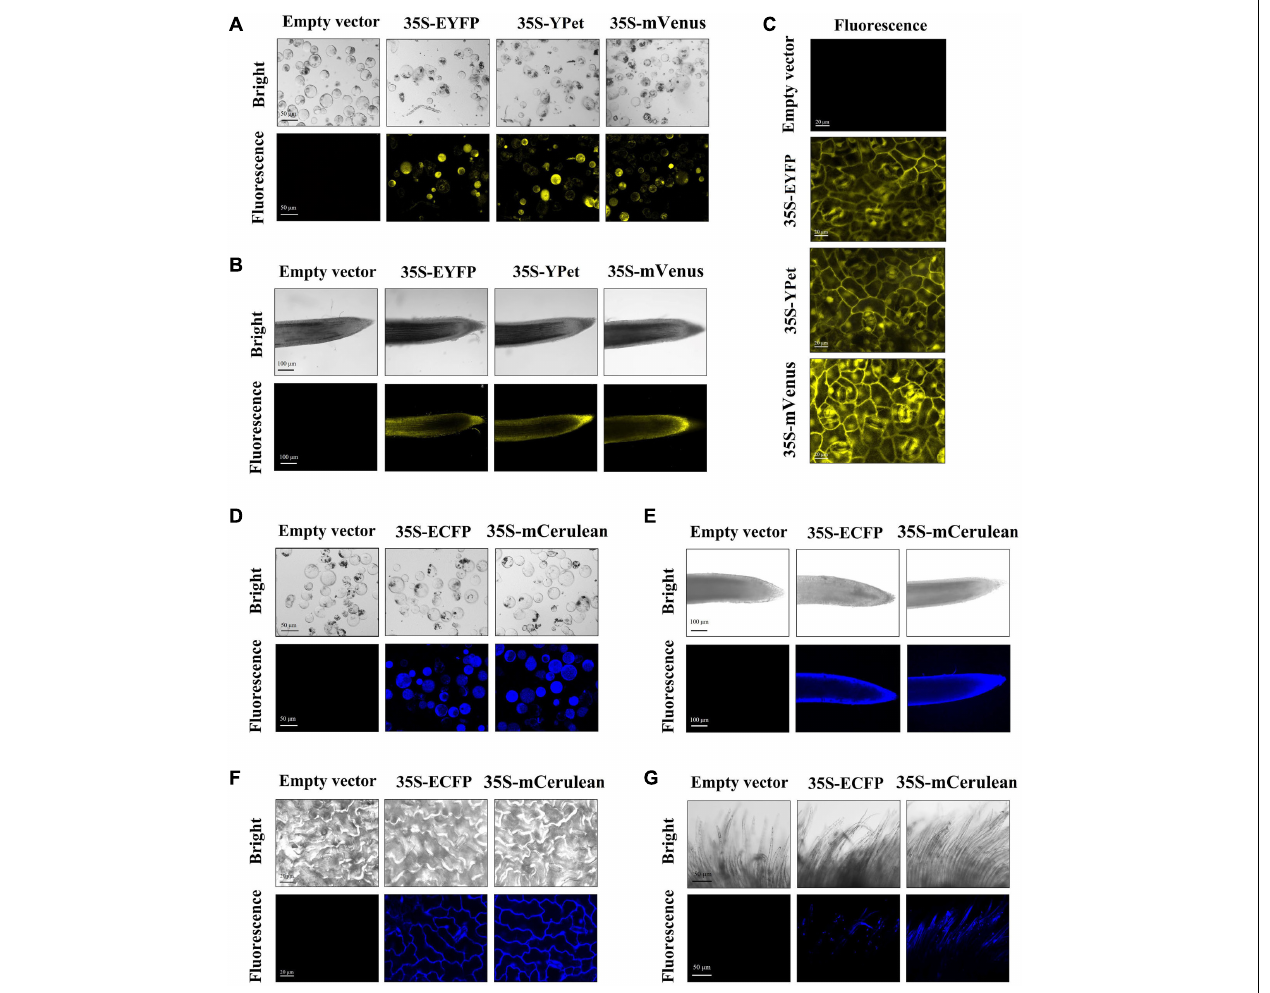
FIGURE 4 | Yellow and cyan fluorescent protein (YFP and CFP, respectively) fluorescence in different tissues/organs of transgenic regenerated T 0 plants. The yellow fluorescence observed in callus protoplast (A) , root (B) , and leaf (C) of empty-vector and YFP-expressing transgenic cotton. YFPs: EYFP, YPet, and mVenus. The cyan fluorescence observed in callus protoplast (D) , root (E) , leaf (F) , and fiber (G) tissues of empty-vector and CFP-expressing transgenic cotton. CFPs, ECFP and mCerulean. Scale bars (white) are defined in